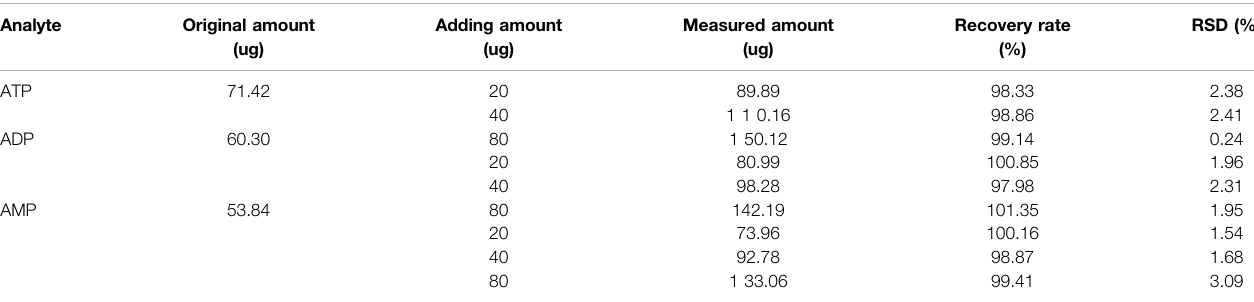
TABLE 4 | Recovery rate experiment results (n (cid:2) 2). Analyte